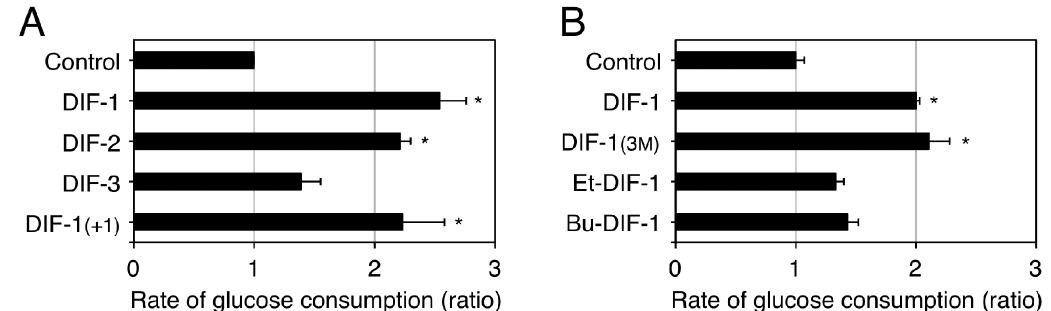
Figure 5. Effects of DIFs on glucose consumption (uptake) by confluent 3T3-L1 fibroblasts. Confluent 3T3-L1 fibroblasts were incubated at 37 ◦ C for at least 8 h in the presence of 0.2% EtOH (vehicle; Control) or 20 µ M of one of the DIF derivatives. The glucose concentration in each incubation medium was measured and the approximate rate of glucose consumption was calculated relative to that in the Control medium; the rate of glucose consumption corresponds well with that of tritium-labeled 2-deoxy-glucose uptake promoted by DIF-1 [84]. The means and SD (bars) of three independent experiments ( A ) or triplicate experiments ( B ) are shown (adapted from Omata et al. [84] and Kubohara et al. [71], respectively). * p < 0.05 versus Control (by t -test; two-tailed, unpaired).